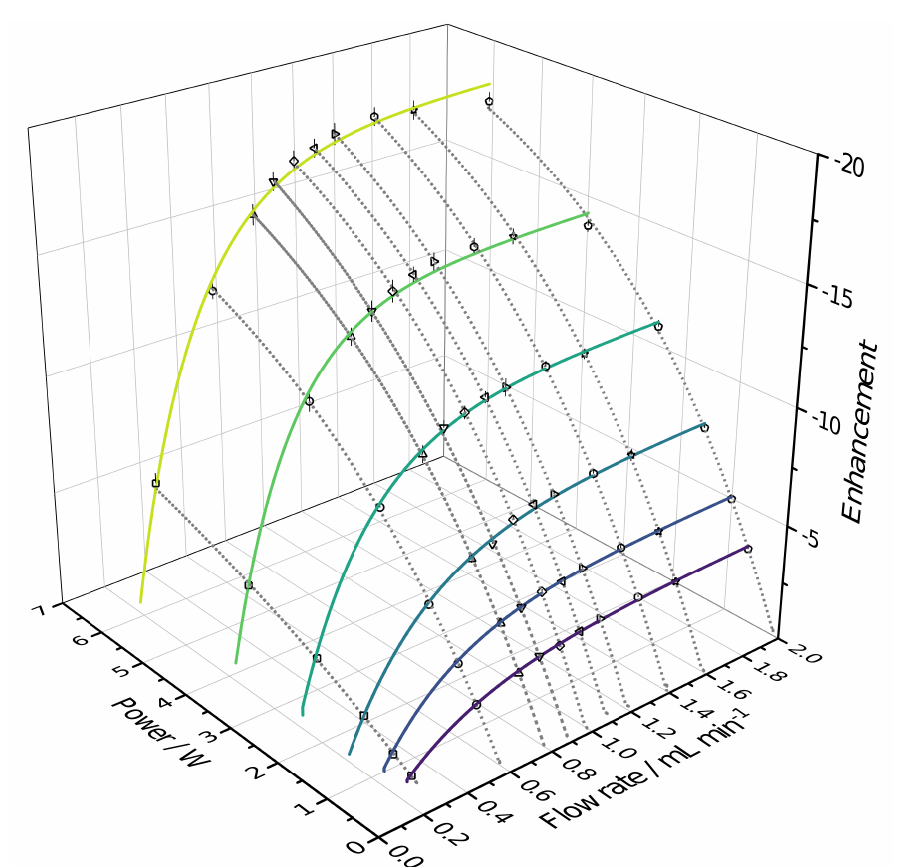
Figure 5. Results from continuous-flow ODNP measurements with water obtained with CPG- PEI25000-GT (pore size 50 nm) versus applied microwave power and flow rate. The symbols are experimental results and were obtained as the arithmetic mean of the results of three individual samples. Solid lines: guide to the eye. Dashed lines: exponential fit